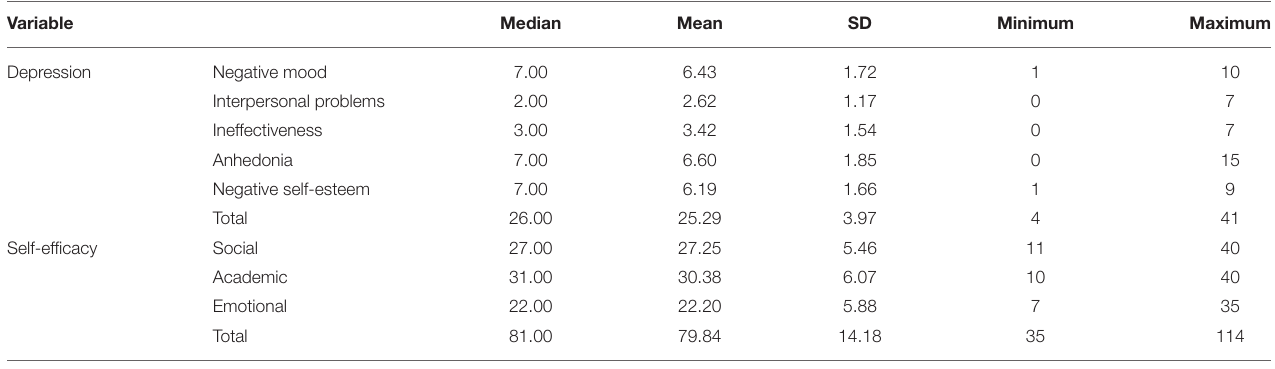
TABLE 3 | Description of the depression and self-efficacy and their dimensions’ scores among children ( n = 321). Variable Depression